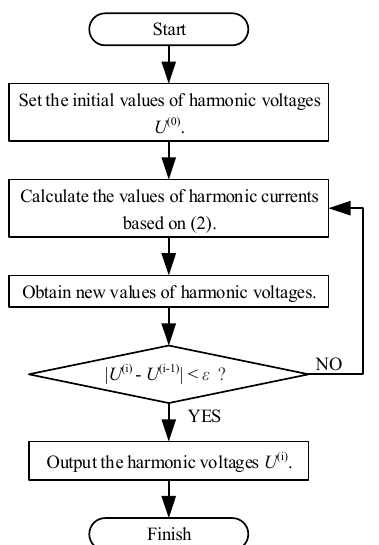
Figure 11. The process of harmonic power-flow calculation.